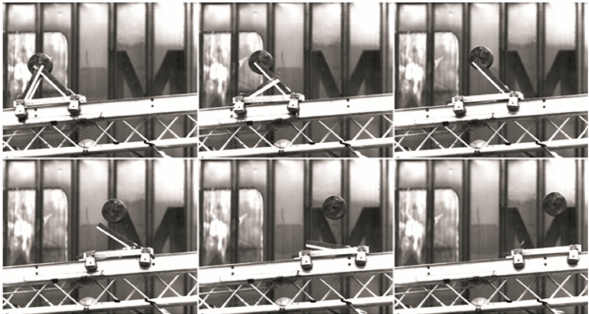
Fig. 3. Image sequence showing the operation of the UAV release on a 15Kg test